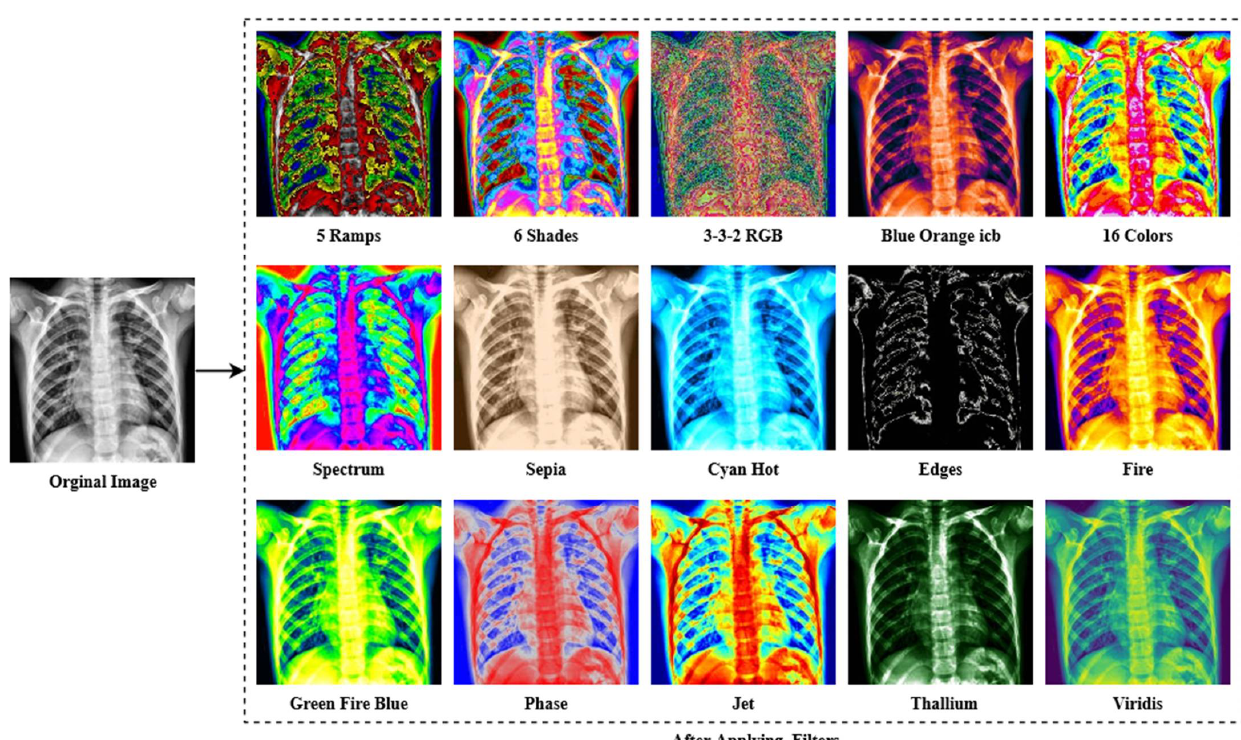
Figure 6. The result of different filtering algorithms includes the following: 5 Ramps, 6 Shades, 3-3-2 RGB, Blue Orange icb, 16 colors, Spectrum, Sepia, Cyan Hot, Edges, Fire, Green Fire Blue, Phase, Jet, Thallium, and Viridis were applied to the X-ray image dataset.